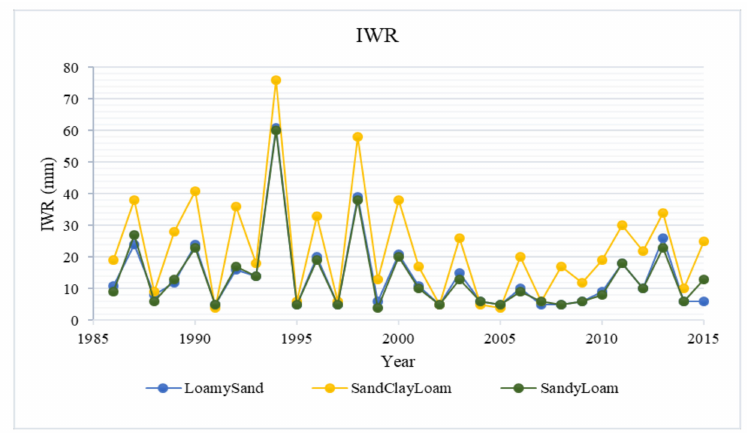
Figure 6. Temporal course of irrigation water requirement (IWR)